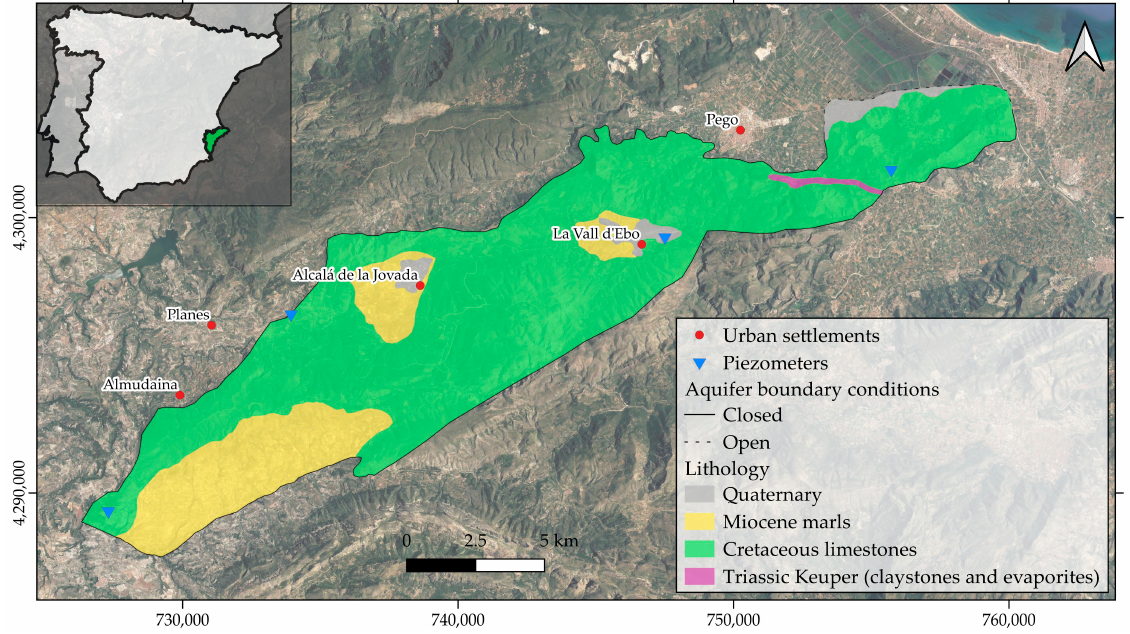
Figure 1. Almudaina-Segaria aquifer, located in Alicante, Spain.